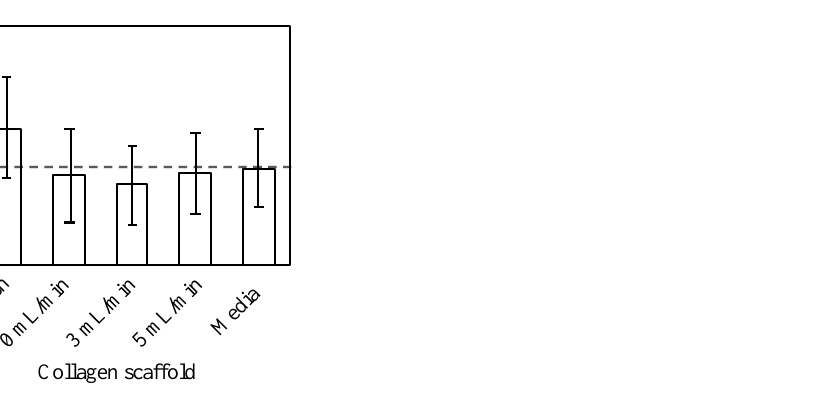
Figure 4. Results of LDH assay ( n = 3~7, mean ± SD). The cell tissue cultured on ubiquitous culture dish released LDH in the media. However, cell tissues cultured using the other methods did not show the release.